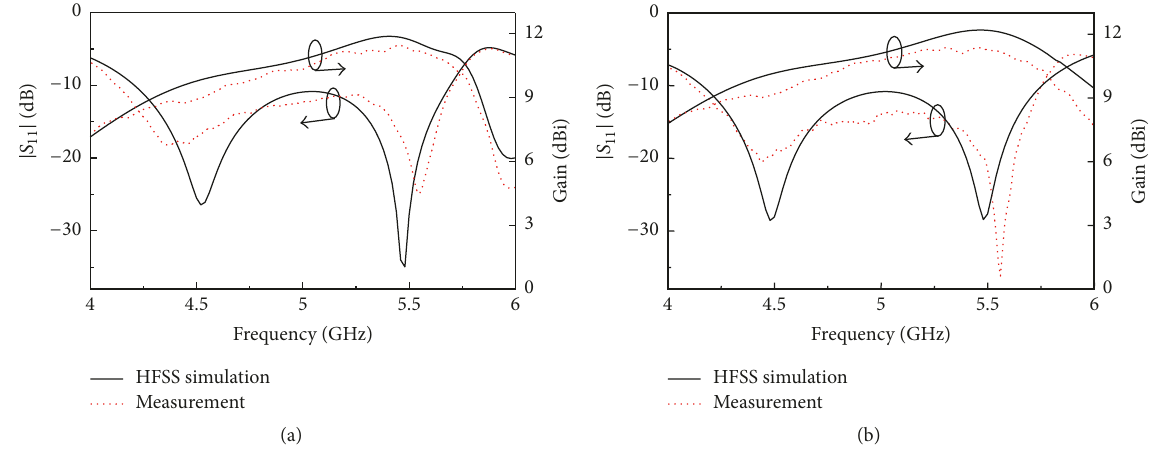
Figure 9: Measured, simulated reflection coefficients and gains of antennas II and III. (a) Antenna II. (b) Antenna